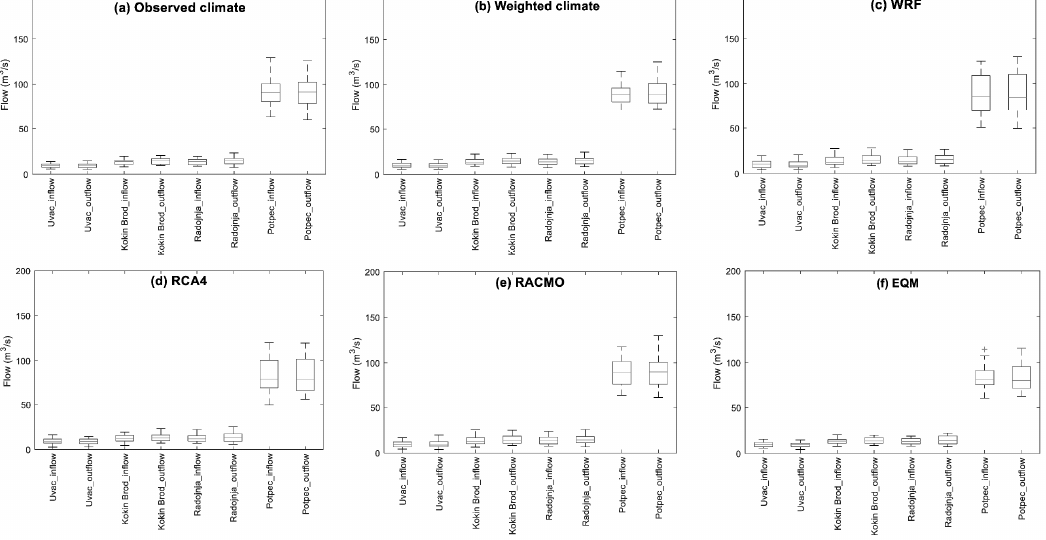
Figure 5. Monthly inflows to and outflows from the Lim water system reservoirs (Uvac, Kokin Brod, Radojnja and Potpec) estimated with the following climate datasets: ( a ) Observed climate, ( b ) weighted climate simulations, ( c, d, e ) regional climate model simulations—WRF, RCA4, RACMO, ( f , g, h, i ) bias correction methods—EQM (empirical quantile mapping), GQM (Gamma quantile mapping),, GPQM Gamma Pareto quantile mapping), CS (constant scaling).